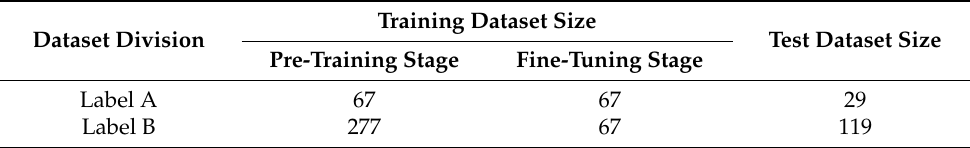
Table 3. The division and usage of the experimental